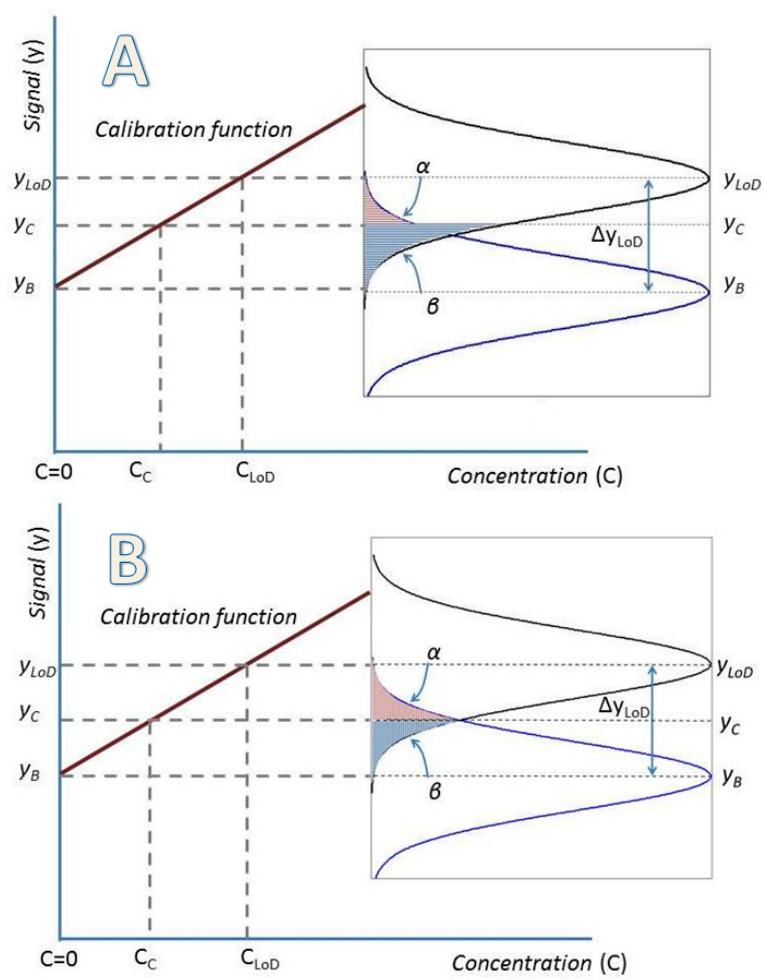
Figure 3. ( A ) Critical value, Limit of Detection, false positives and false negatives for the general case; ( B ) Critical value, Limit of Detection, false positives and false negatives for the case α = β .